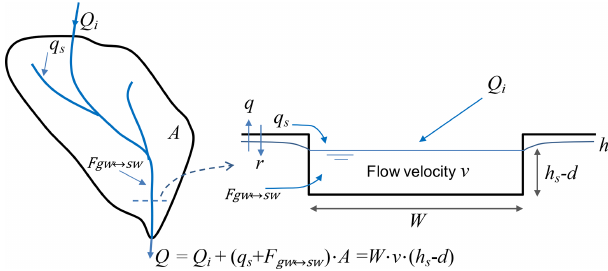
Figure A1. Contributing fluxes to